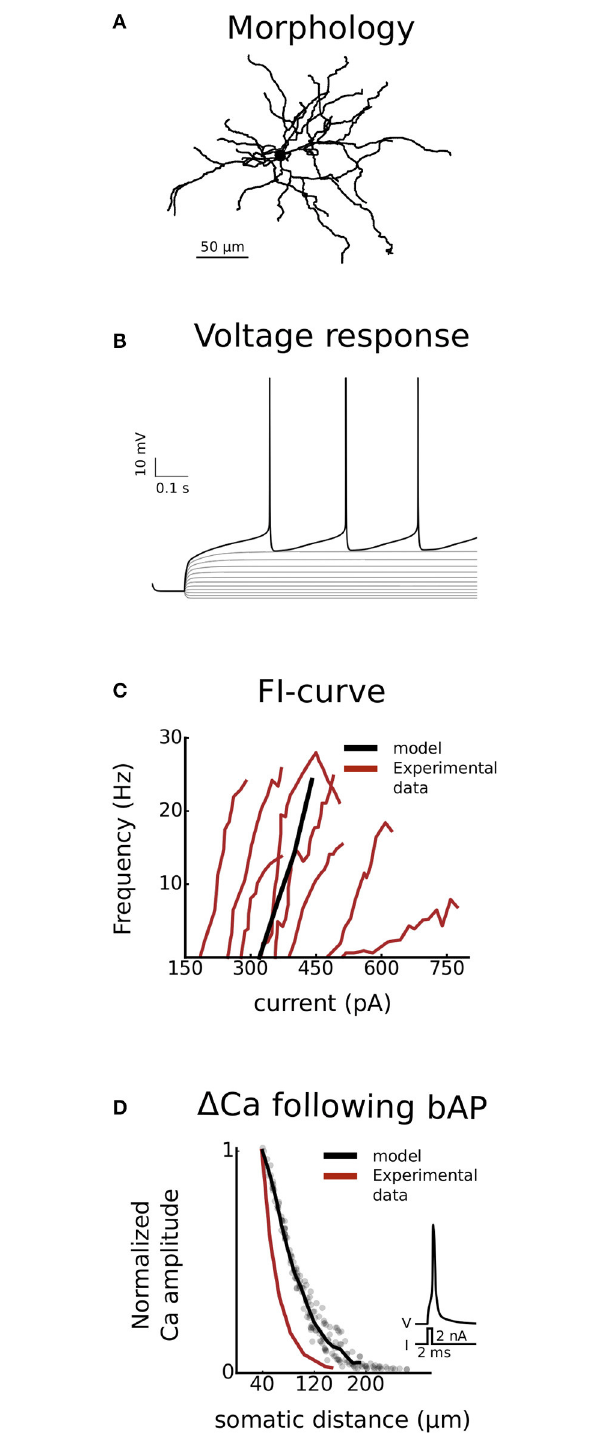
FIGURE 2 | Validation. The model is validated against experimental data from striatonigral medium spiny neurons of the direct basal ganglia pathway. Both somatic ( B and C ) as well as dendritic excitability (D) is validated. In (A) , the dendritic arborisation of the morphology is shown. (B) is showing the voltage response of the cell, following current injections ranging from − 100 to 340 pA